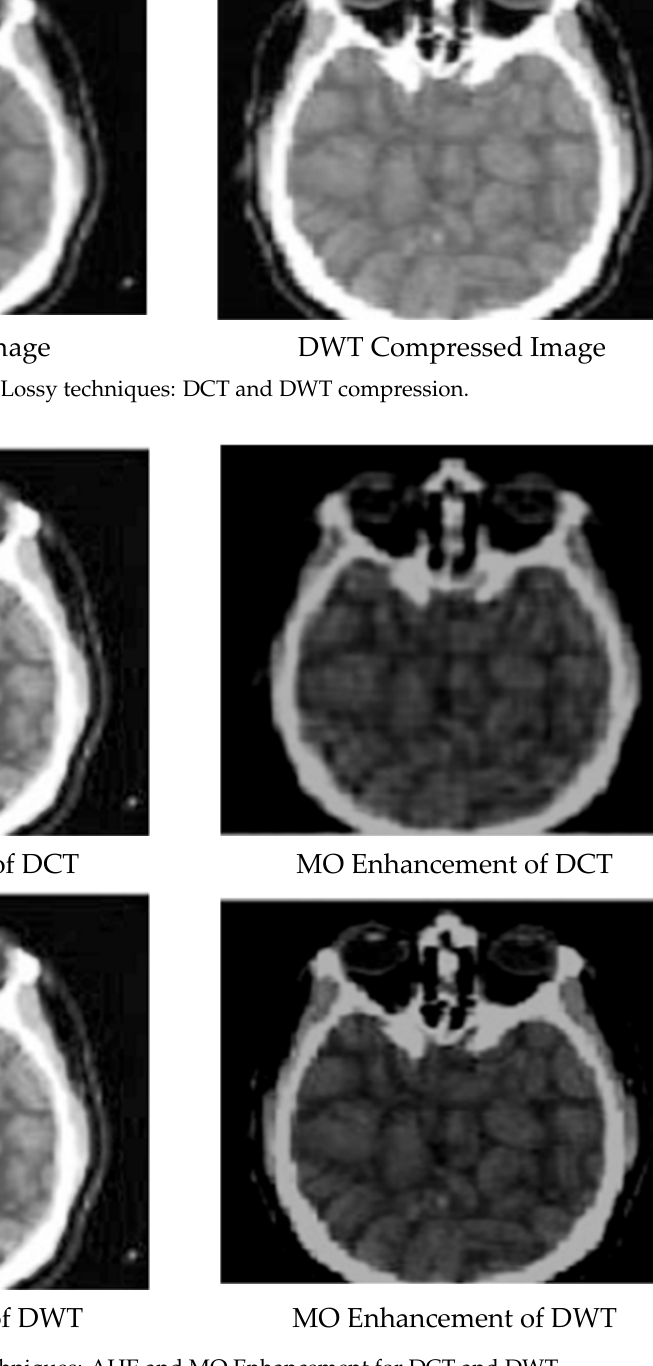
Figure 2. Lossy techniques: AHE and MO Enhancement for DCT and DWT.